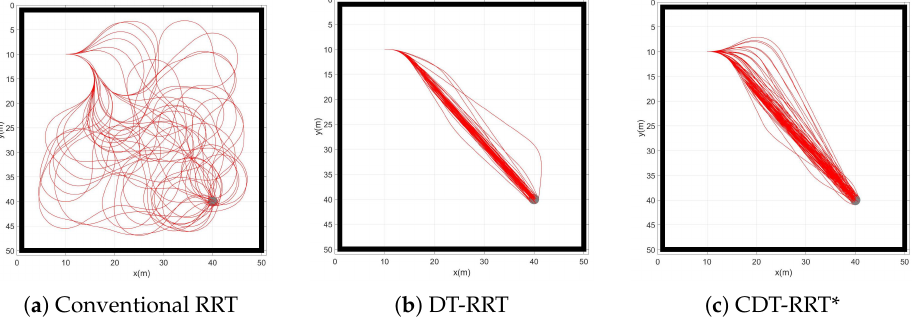
Figure 4. Resultant trajectories from simulation